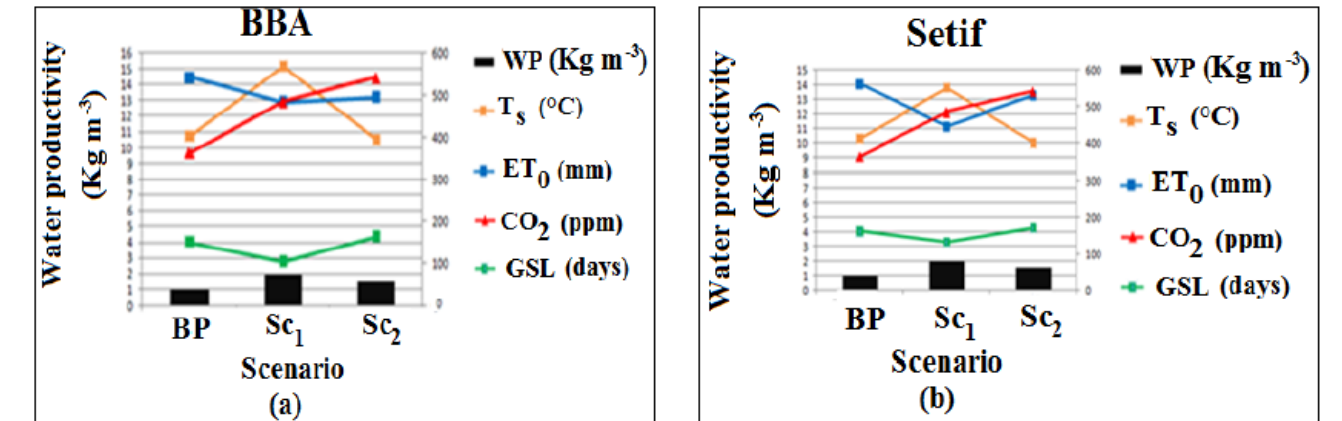
Figure 5. ( a , b ) Impact of temperature and CO 2 concentrations futures changes on reference evapo- transpiration and wheat water productivity and the growing cycle